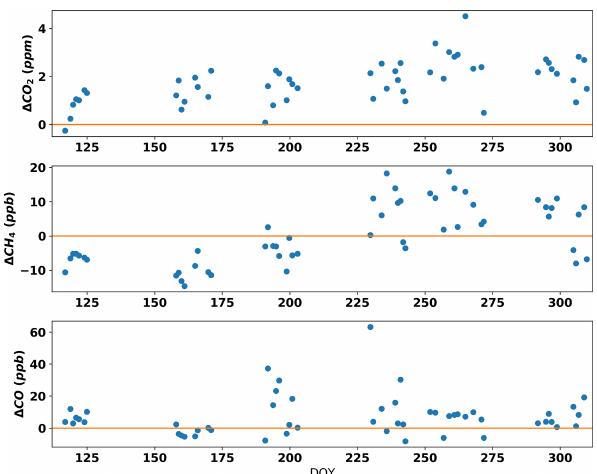
Figure 7. Difference (observations–model) between mean daily free troposphere (3000–5000ma.s.l. for CO 2 and CH 4 and 4000–5000ma.s.l. for CO) for GEOS-simulated and Arctic-CAP- observed mole fractions. The GEOS simulations systematically un- derestimate the mean CO 2 in all months, while the model overesti- mates CH 4 before DOY 200 and underestimates CH 4 after DOY 200. Simulated CO observations generally agree with the atmo- spheric observations, although there are sporadic underestimates likely associated with incorrectly modeled fire